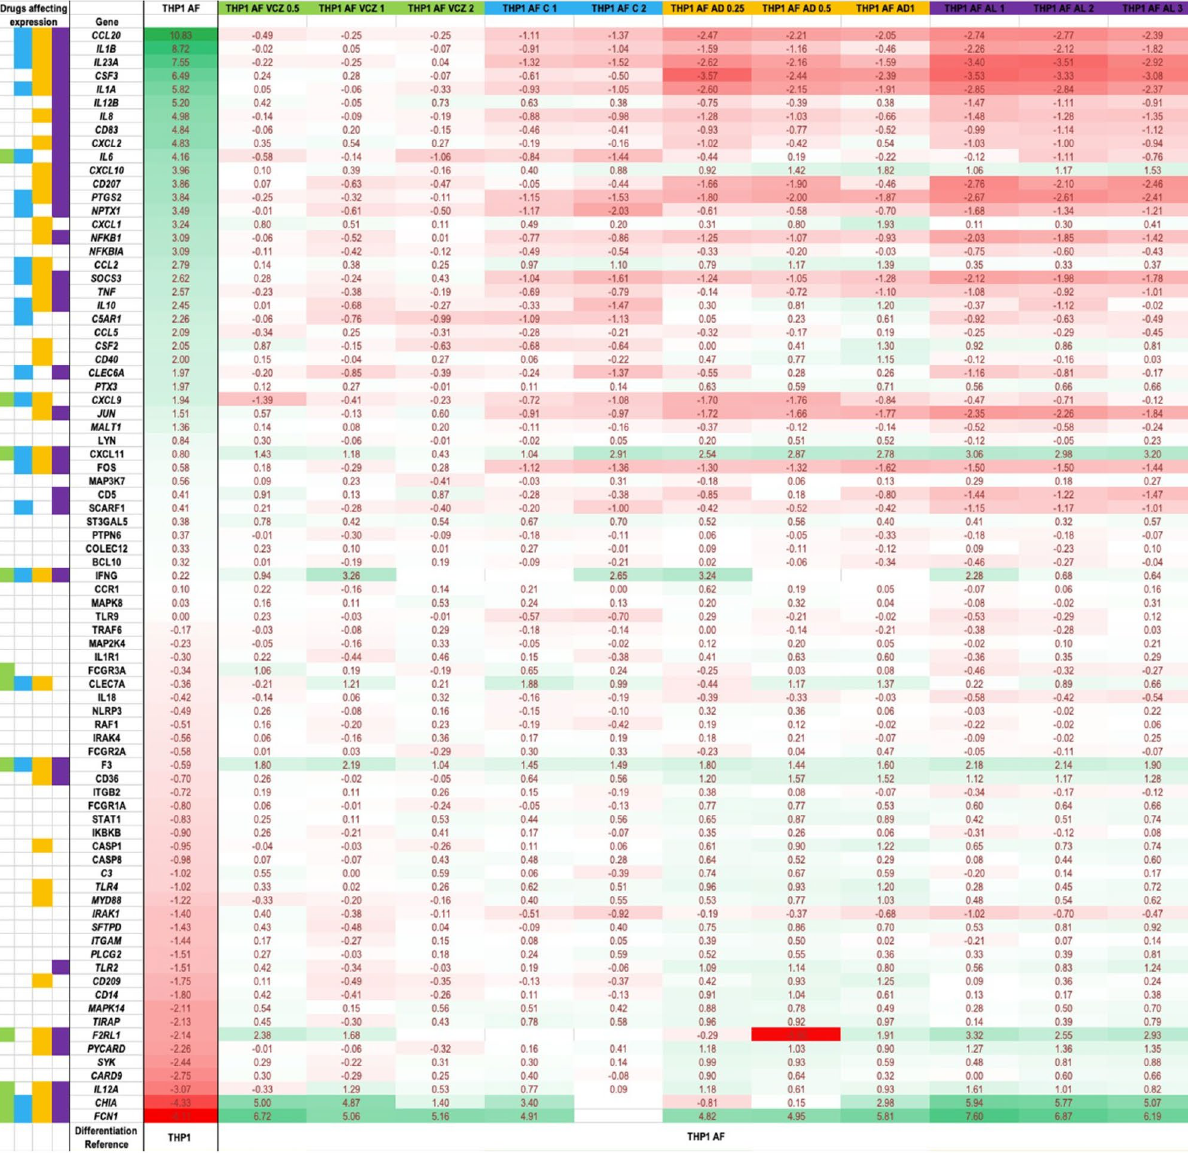
Figure 2. Log 2 (fold change) of gene expressions for 84 genes (rows) across 12 experimental conditions (columns). For column THP1 AF, the reference of differentiation is THP1 only. For the remaining columns, the reference is THP1 AF (infected, non-treated cells). Genes are sorted according to the intensity of their expression in THP1 AF column. A log2(fold change) ≥ 1 was of interest, and corresponding genes names are highlighted in green (up-regulation) and in red (down-regulation). Across antifungals-treated experimental conditions, fold regulations of interest are highlighted in corresponding colour on the left side (voriconazole: green; caspofungin: blue; amphotericin B deoxycholate: orange; liposomal amphotericin B: purple). AF: Aspergillus fumigatus ; VCZ: voriconazole; C: caspofungin; AD: amphotericin B deoxycholate; AL: liposomal amphotericin B. Drug concentrations are in